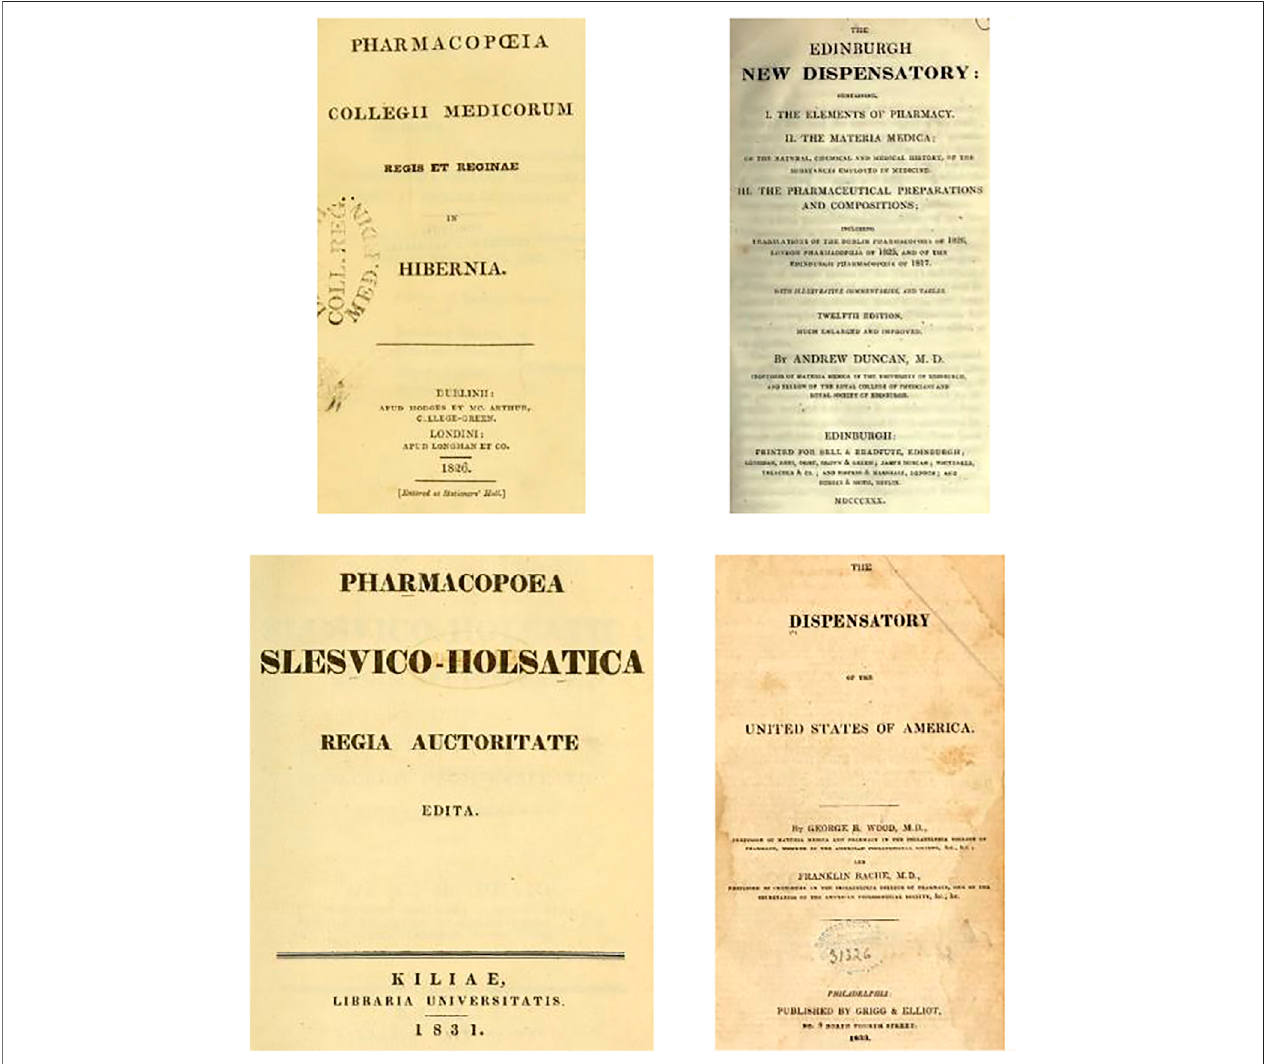
FIGURE 5 | Title pages of the earliest pharmacopeia entries for buchu in chronological order: Dublin pharmacopoeia 1826, Edinburgh dispensatory 1830, Schleswig-Holstein pharmacopoeia 1831, US dispensatory 1833.